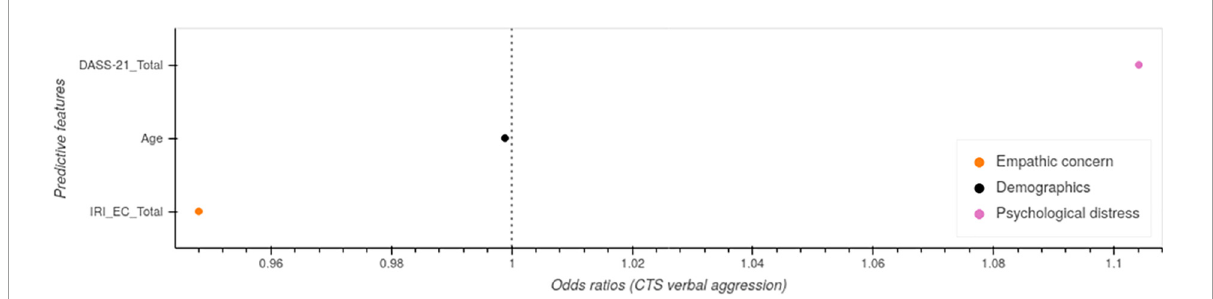
FIGURE2 Regularized regression model predicting verbal aggression toward children (Time 3).